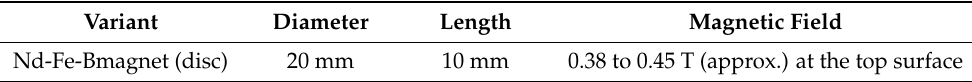
Table 3. Selected properties of the magnet.